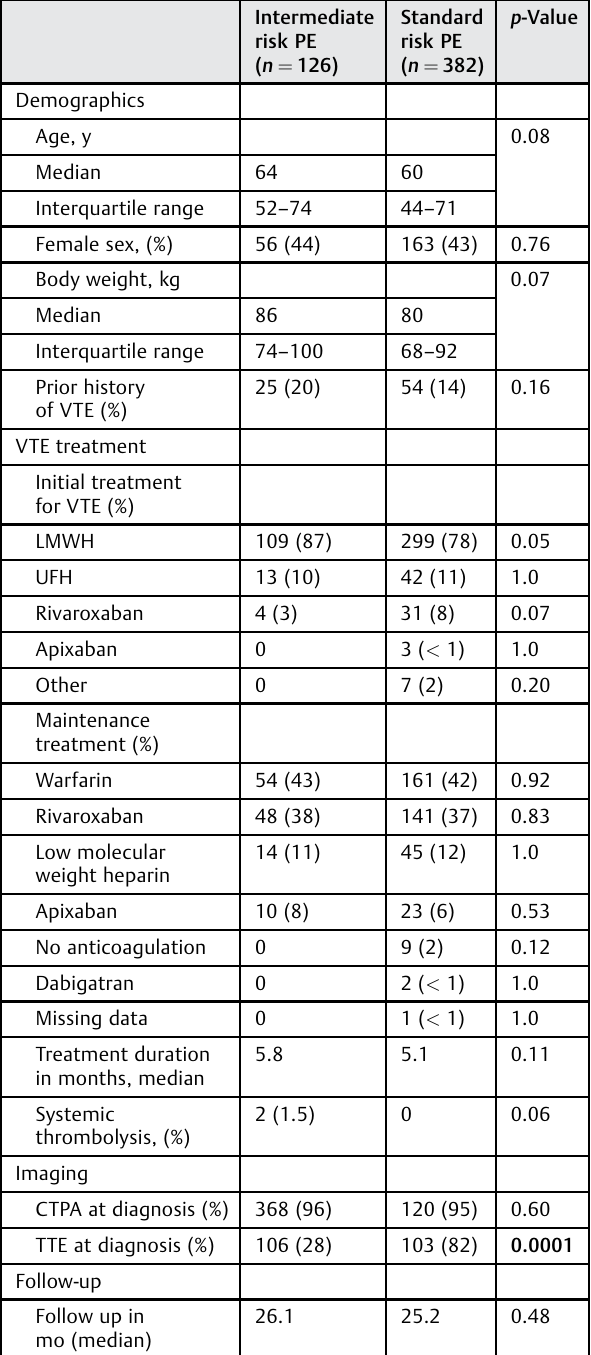
Table 2 Baseline characteristics of study